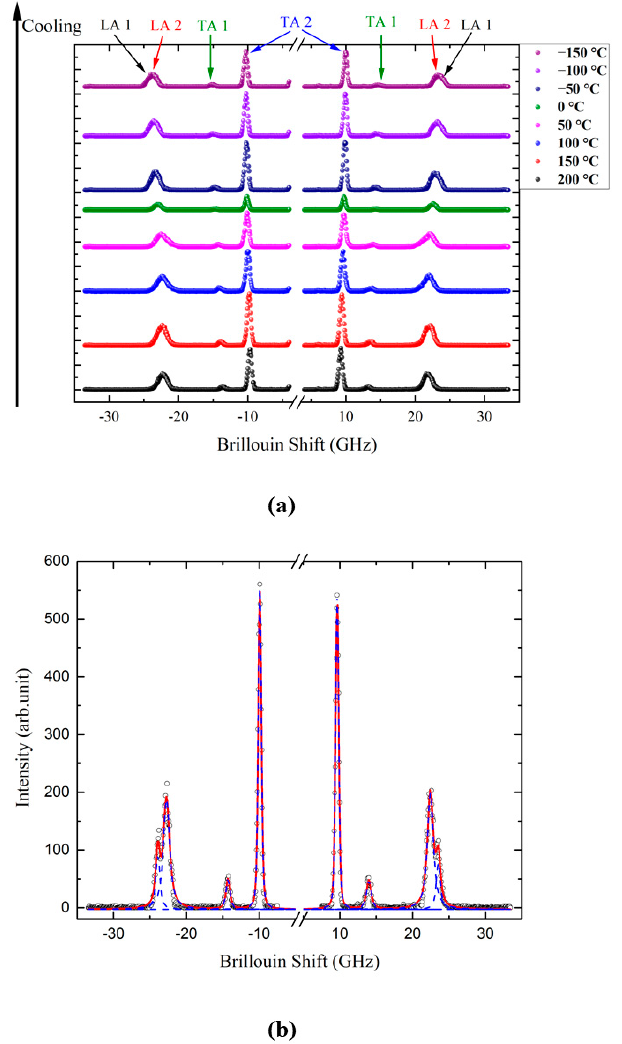
Figure 2. ( a ) Brillouin spectra of a taurine crystal at a few temperatures. ( b ) The Brillouin spectra of a taurine crystal measured at 30 °C and the fitting lines for each acoustic mode.